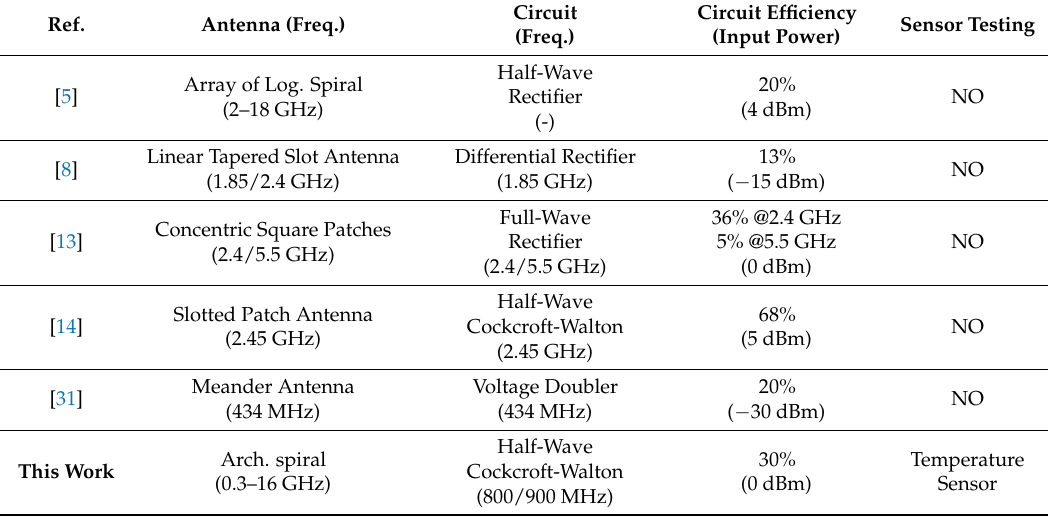
Table 1. Comparison among different RF energy harvesting